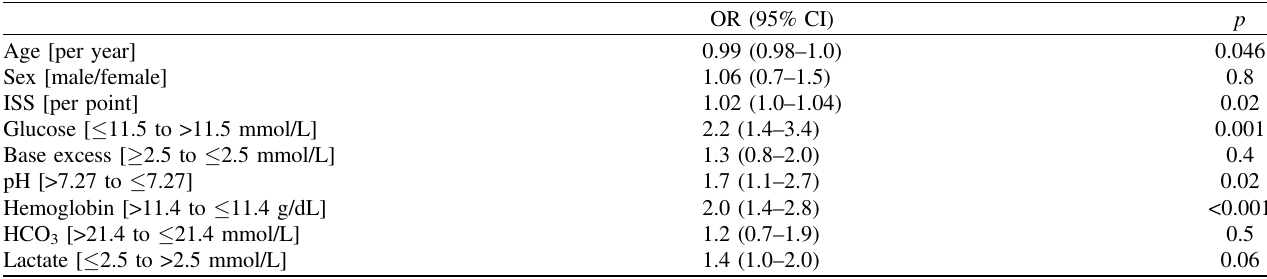
Table 2. Multivariate regression analysis with odds ratio (OR) and 95% con fi dence interval (95% CI) of clinical and laboratory indicators of shock at admission in multiply injured